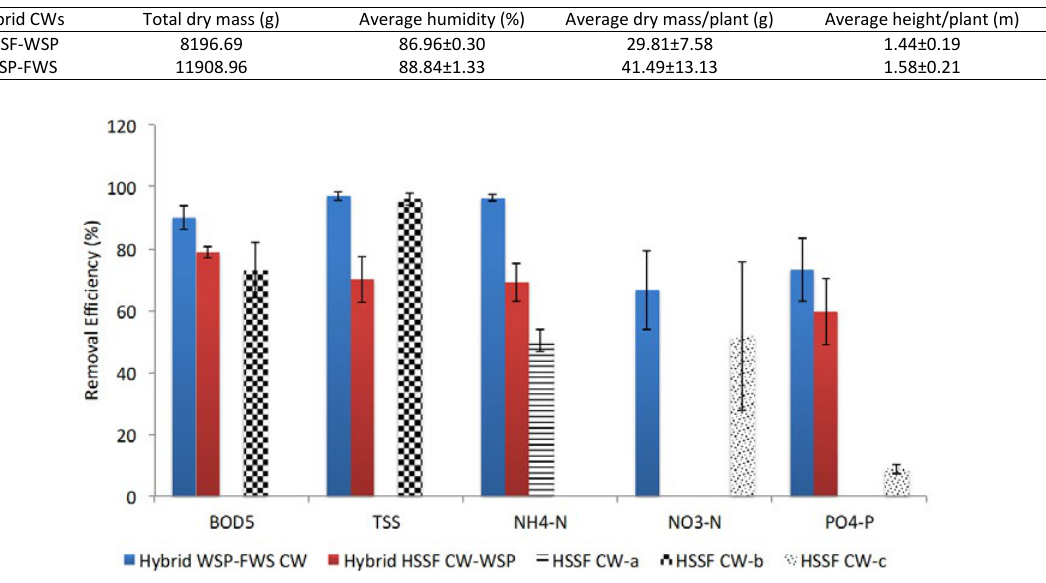
Table 3: Comparison of biomass growth in the two hybrid CWs